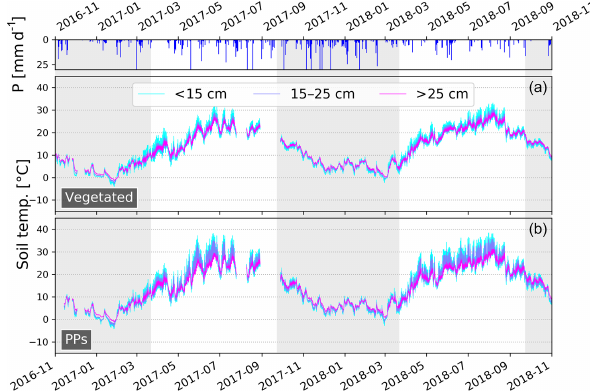
Figure 8. Mean soil temperatures measured in different depths for vegetated (a) and paved surfaces (b) . The grey background indicates the winter half